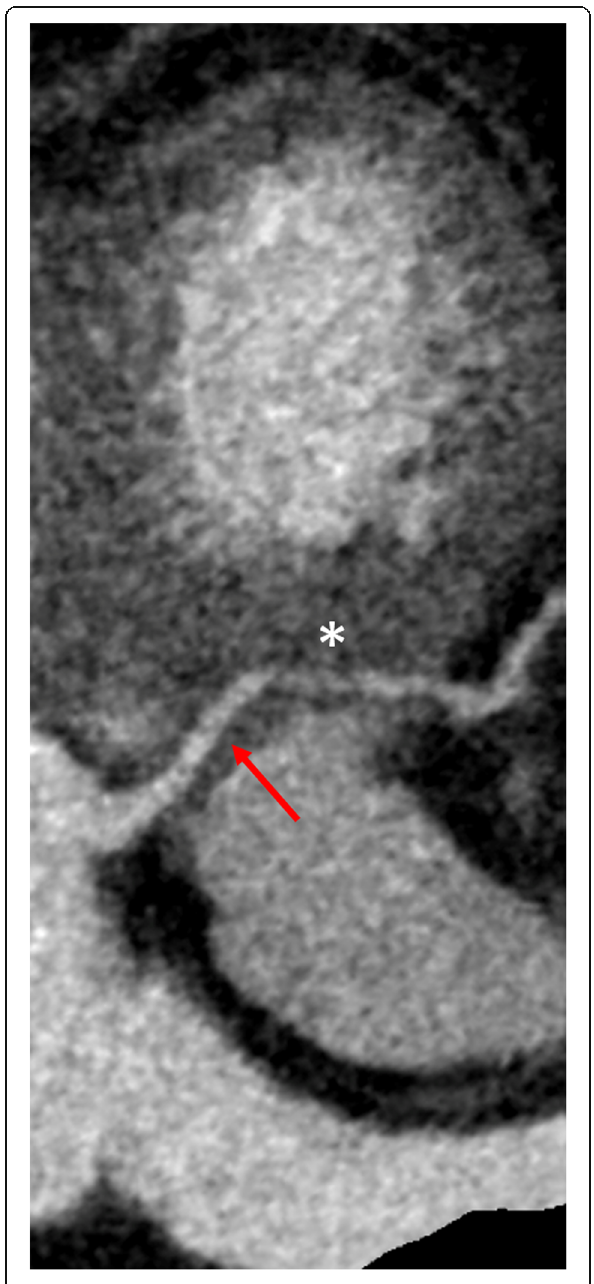
Fig. 2 CCT MPR showing the left main coronary artery (red arrow) coursing in the interventricular septum (asterisk)